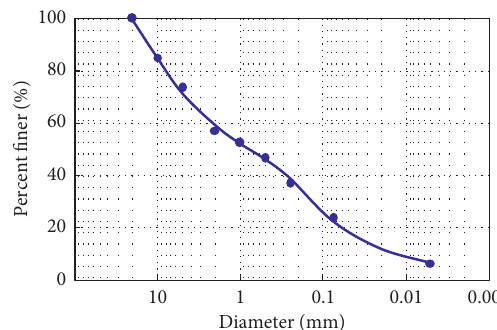
Figure 2: Grain-size distribution of the soil used in the